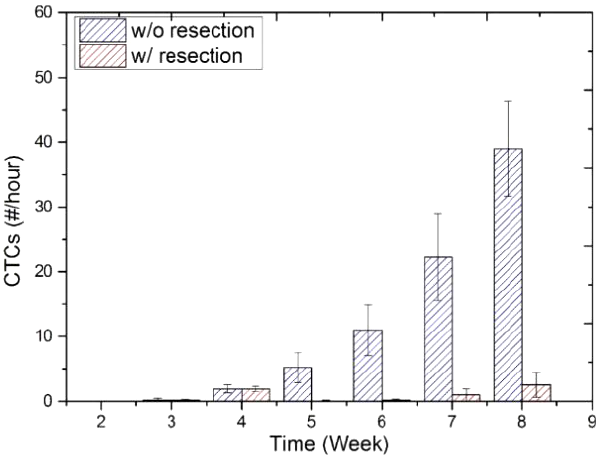
Fig. 4. The comparison of CTC dynamics and tumor growth between a subcutaneous and an orthotopic metastatic tumor model: CTC counts of the subcutaneous and the orthotopic metastatic tumor model measured by IVFC during eight weeks after tumor implantation. The measurement was carried out once a week and last at least 1 h each